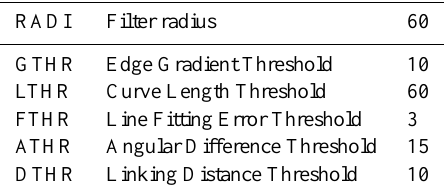
Table 1. Chosen parameter for LINE